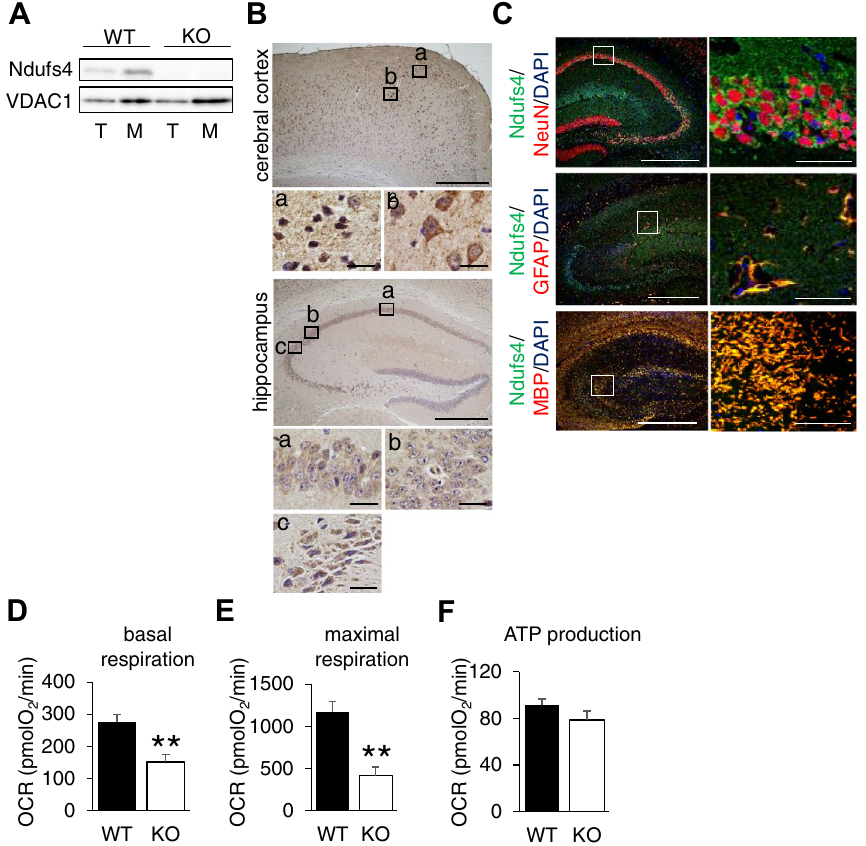
Figure 1. Expression and localization of Ndufs4 in cerebral cortex and hippocampus. ( A ) Representative image from Western blot for Ndufs4 in brain of WT and Ndufs4-KO mouse. T: total protein, M: protein from isolated mitochondria. ( B ) Representative image from enzyme-based immunohistochemistry showing the expression of Ndufs4 in cerebral cortex and hippocampus. Insets enlarge the boxed area. Scale for low magnification: 500 µm, for high magnification: 50 µm. ( C ) Representative image from co-immunofluorescence staining of Ndufs4 (Green) with NeuN, GFAP and MBP (red) in hippocampus of WT mouse. Boxed area is enlarged on right. Scale for low magnification: 500 µm, for high magnification: 40 µm. ( D – F ) Mitochondrial complex I respiration assay by XF24 analyser using isolated mitochondria from punch out hippocampus of WT (n = 3) and Ndufs4-KO (n = 3)